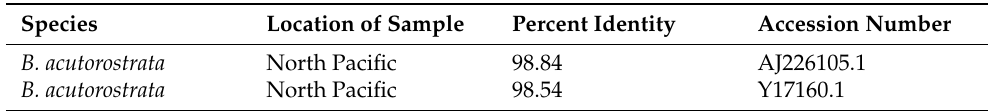
Figure 3. Dorsal ( a – c ) and ventral ( d – f ) views of the cranial bone of the unknown whale in this study ( a , d ), compared to B. acutorostrata ( b , e ) and B. omurai ( c , f ) from a previous study by Yamada , et al., 2006 [27]. Labels: 1 = maxilla bone, 2 = premaxilla bone, 3 = supraorbital process of frontal bone, 4 = supraoccipital bone, 5 = zygomatic process, 6 = temporal fossa, 7 = parietal bone, 8 = palatine bone, 9 = squamosal bone, 10 = tympanic bulla, 11 = postglenoid process, m = median angle of cranial border of the temporal bone, and asterisk = nasal bone. Table 2. Percent identity, based on the Basic Local Alignment Search Tool (BLAST) available at the National Center for Biotechnology Information (NCBI) GenBank, of